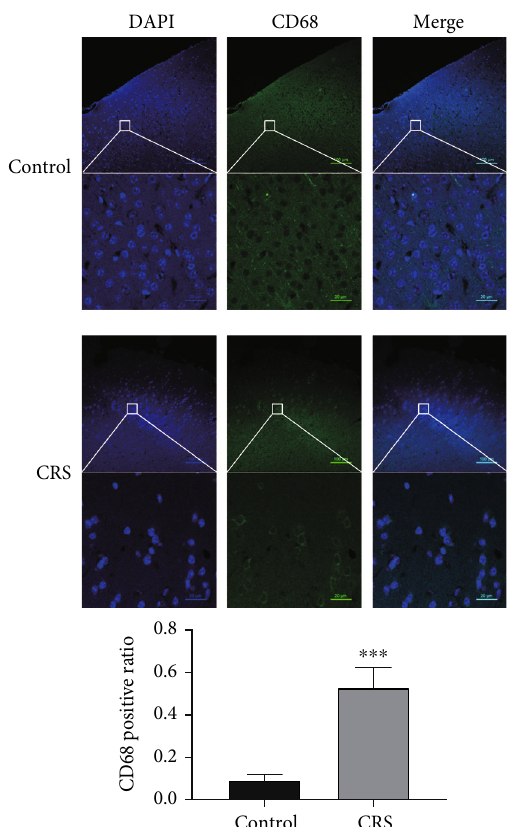
Figure 2: CRS increased in fi ltration of CD68 + -positive cells. Immuno fl uorescence staining of CD68 + showed that CRS could induce a larger number of macrophage in fi ltration. The fi gures are shown at 200x and 1000x magni fi cation. Values are mean ± SE . ∗∗∗ p < 0 : 001 , as compared with the control